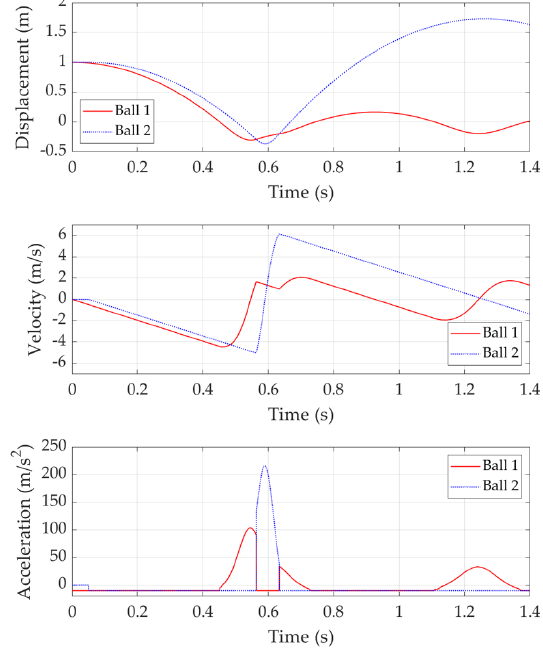
Figure 7. Double bounce with 0.05s release time delay.